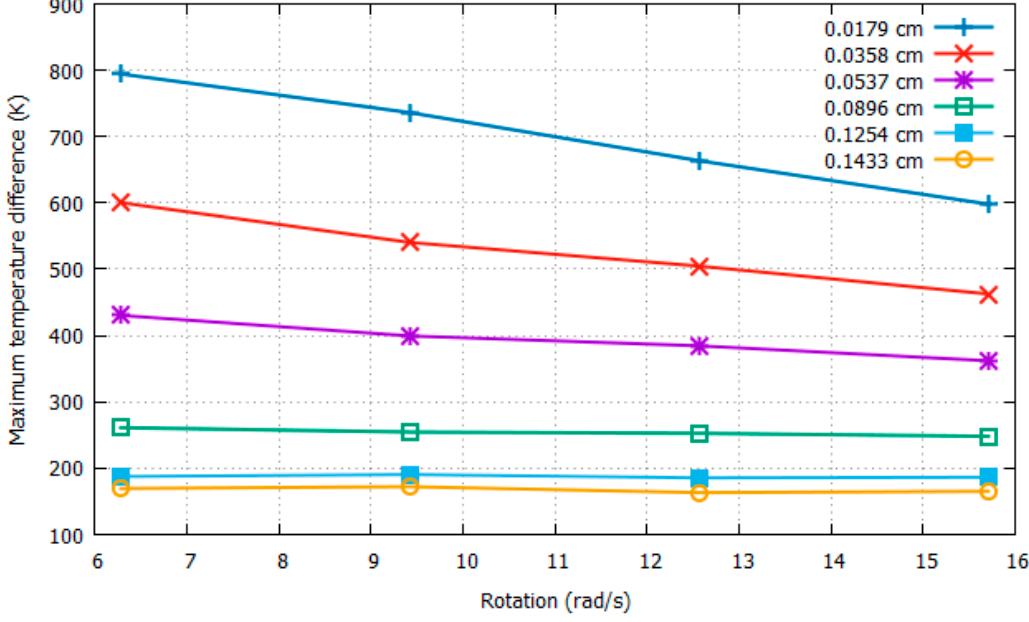
Figure 10. Δ T_Y max w.r.t rotation at 3 g with varying distances between heater and sensors. Figure 10. ∆ T_Y max w.r.t rotation at 3 g with varying distances between heater and